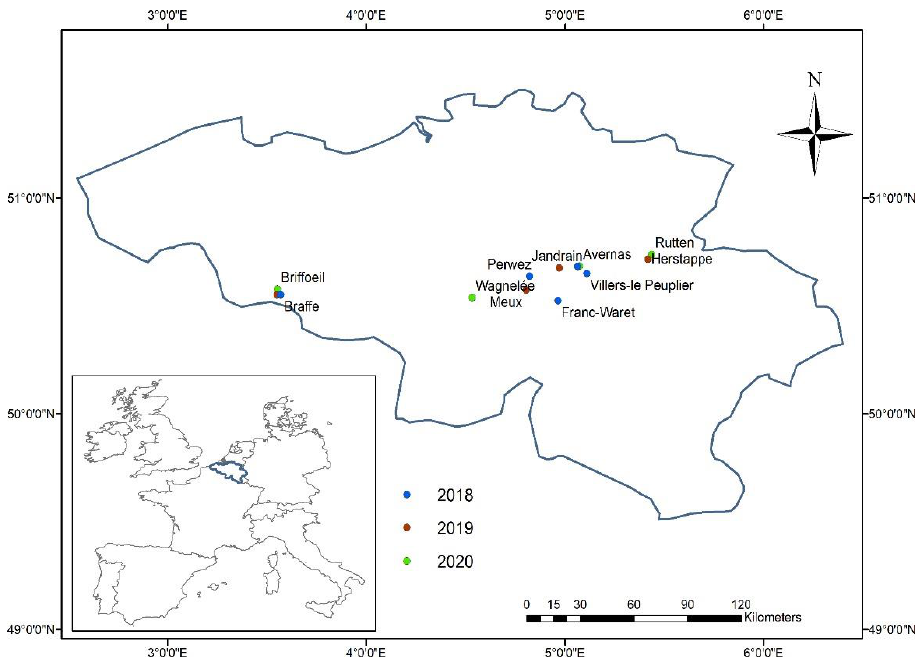
Figure 1. Locations of the sugar beet/Cercospora leaf spot study sites during the 2018 to 2020 cropping seasons in Belgium. Table 1. Agronomic information for the experimental fields of sugar beet used for assessing Cerco- spora leaf spot in Belgium during the 2018 to 2020 cropping seasons.